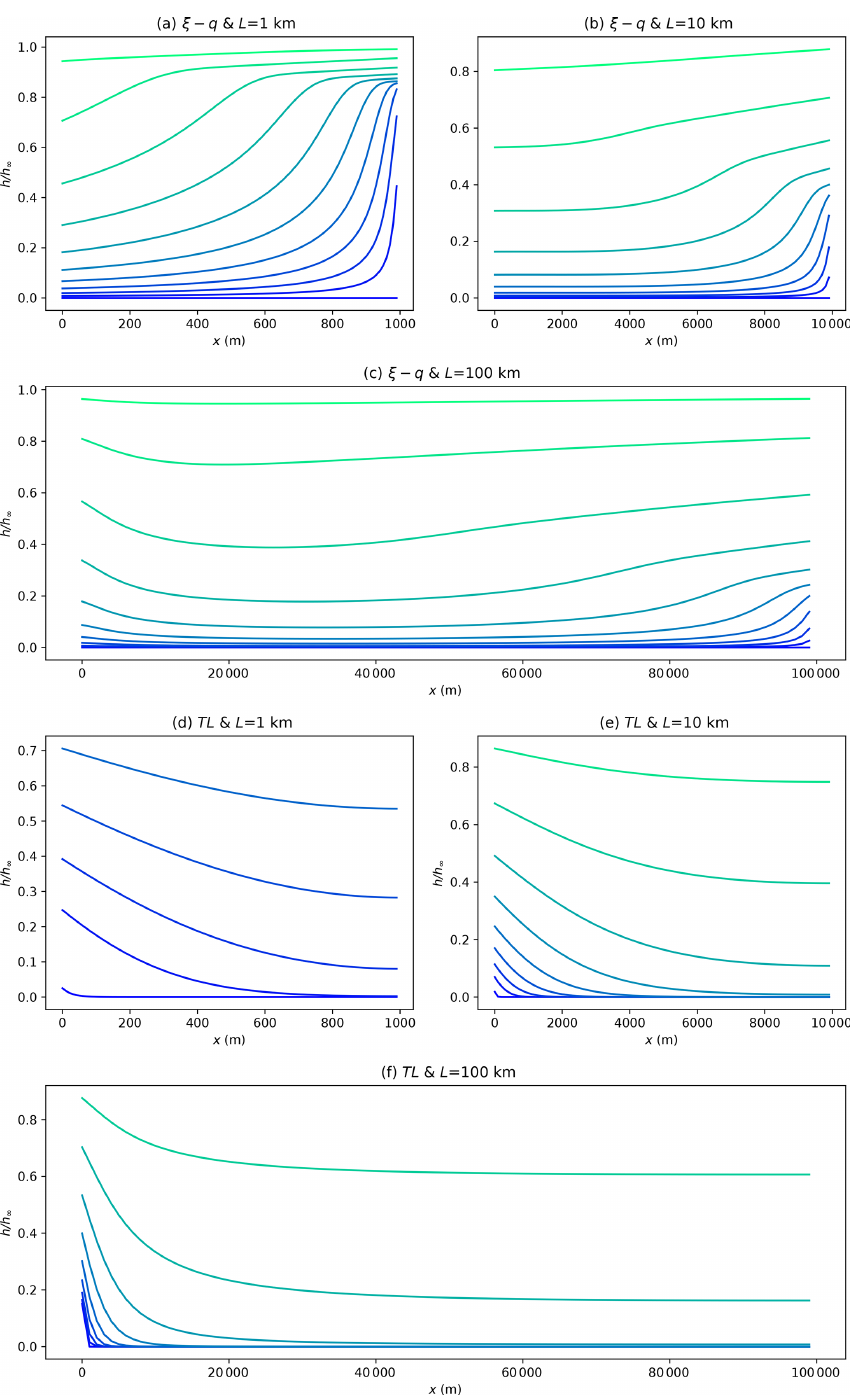
Figure 7. The same information as in Fig. 6 but using the relative surface topography, i.e., scaled by its steady-state value.